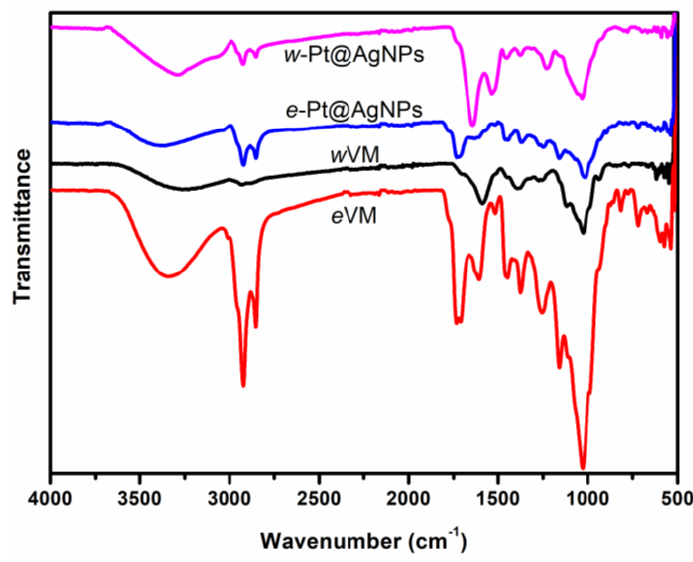
Figure 4. Fourier transform infrared spectra of ethanolic and aqueous VM extracts and their corre- sponding Pt@AgNPs.